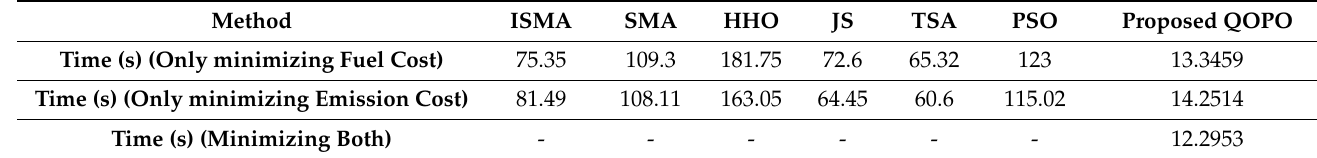
Table 15. Comparison of computational time for 10-unit system.